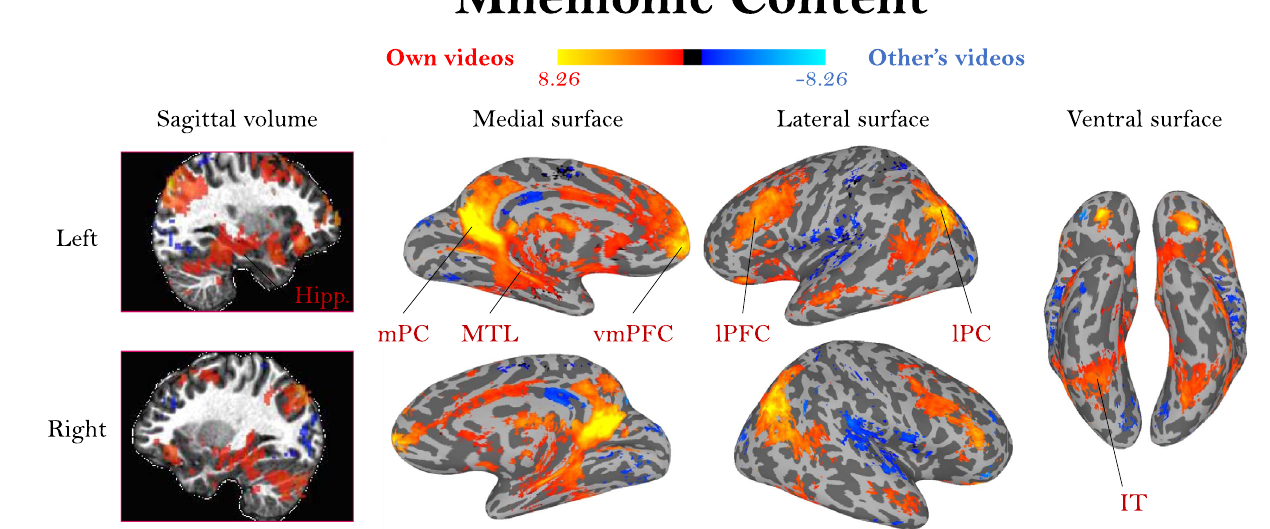
Fig.4|Activationdifferencesbasedonvideomnemoniccontent. Awhole-brain group activation map ( N =32) for viewing one ’ s own videos (red/yellow) versus viewing another person ’ s videos (blue), two-sided t-test, FDR-corrected, q <0.01. The colormap represents the range of beta values. Because participant pairs had identicalvisualcontent,thesepatternsshouldsolelyrepresentactivationrelatedto